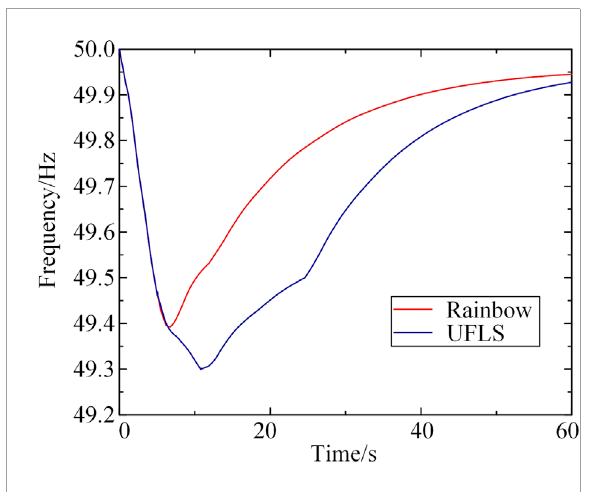
FIGURE 8 Curve of frequency inertia center after action of UFLS and Rainbow algorithm.